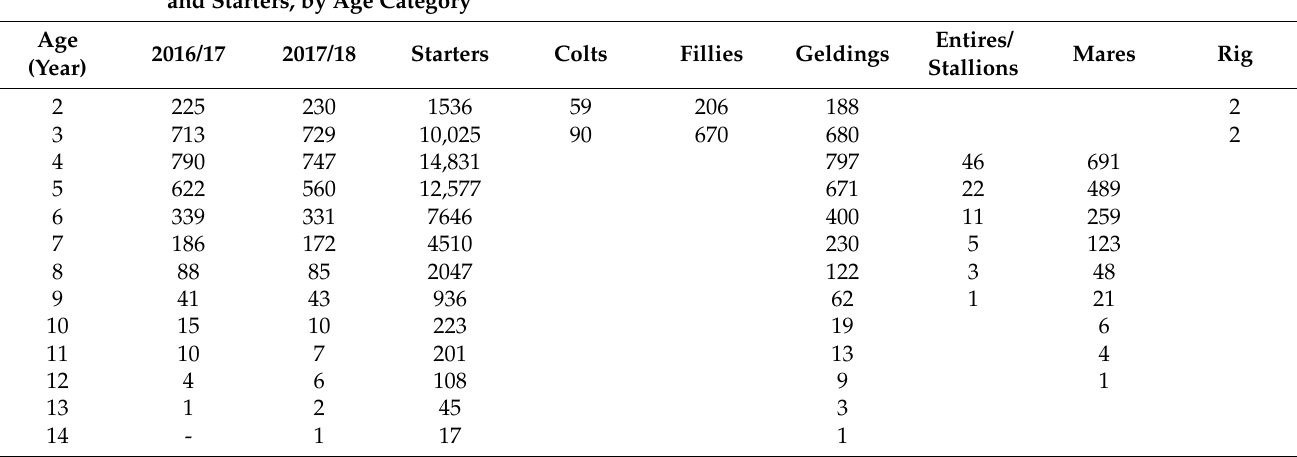
Table 1. Population distribution of horses participating in the 2015/2016 and 2016/2017 New Zealand harness racing